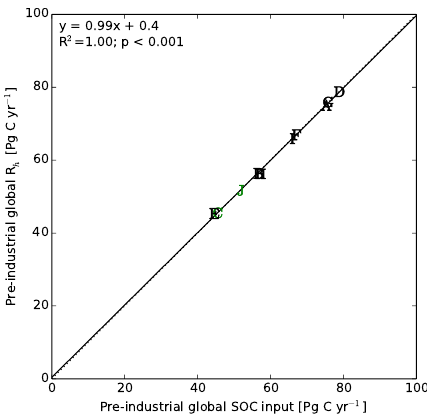
Figure 2. Relationship between pre-industrial global SOC input and pre-industrial R h . Letters are the same as in Table 1 and models in green (i.e. C and J) integrate nitrogen limitation. The solid line is a linear relationship constructed using all models with equation, R 2 and p values indicated in the top left corner. The dotted line represents the 1 : 1